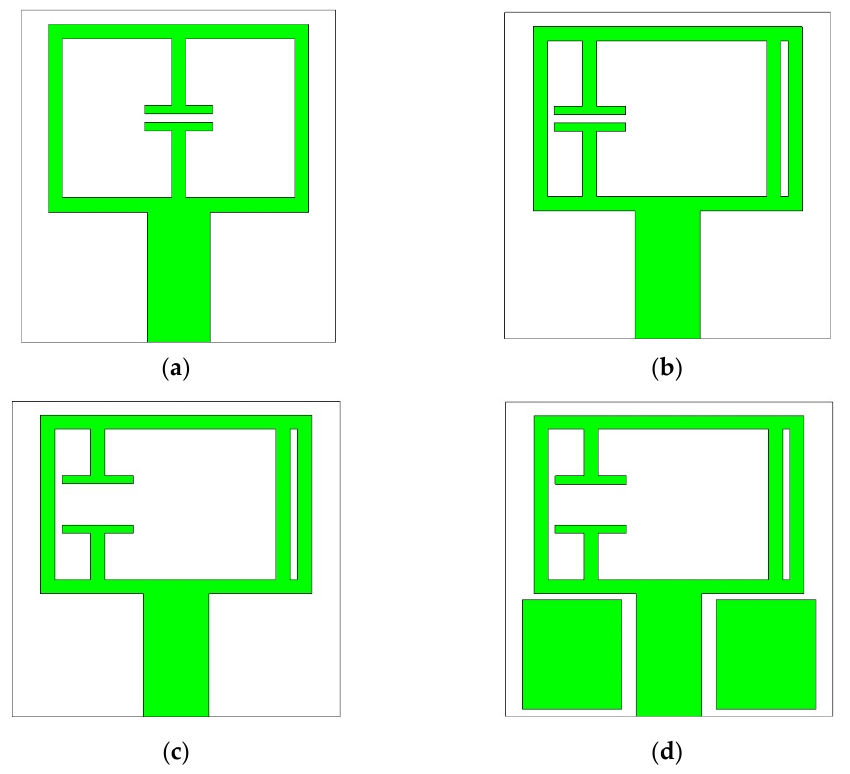
Figure 7. Patch of ( a ) Antenna 1; ( b ) Antenna 2; ( c ) Antenna 3; ( d ) Antenna 4.